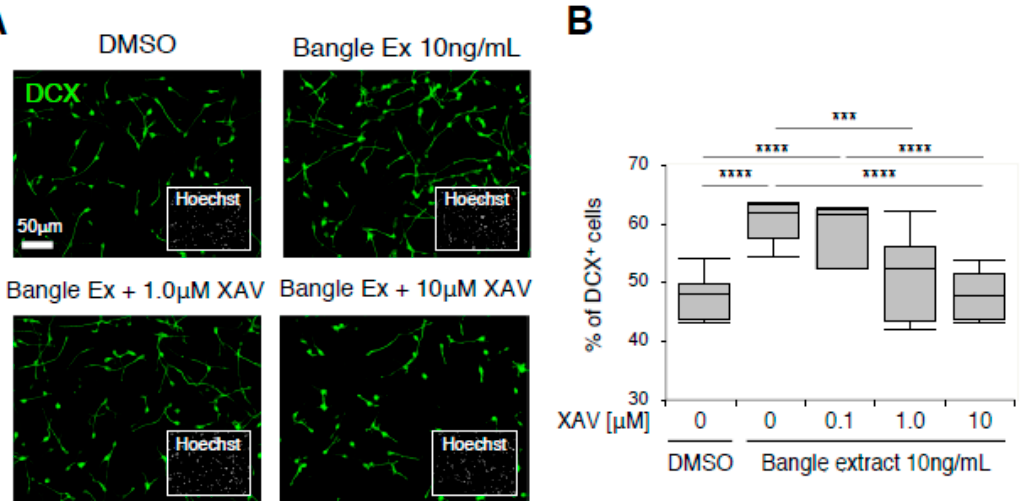
Figure 4. WNT signaling is responsible for the promotion of neuronal di ff erentiation in response to Bangle extract treatment. ( A ) Cells treated with 10 ng / mL Bangle extract and the WNT signaling inhibitor XAV-939 were stained with antibodies against DCX (green) 7 days after induction of di ff erentiation. ( B ) The graphs indicate the percentage of total cells that were DCX-positive. The values shown are the means ± SD. ( N = 6, ANOVA, *** p < 0.005, **** p <